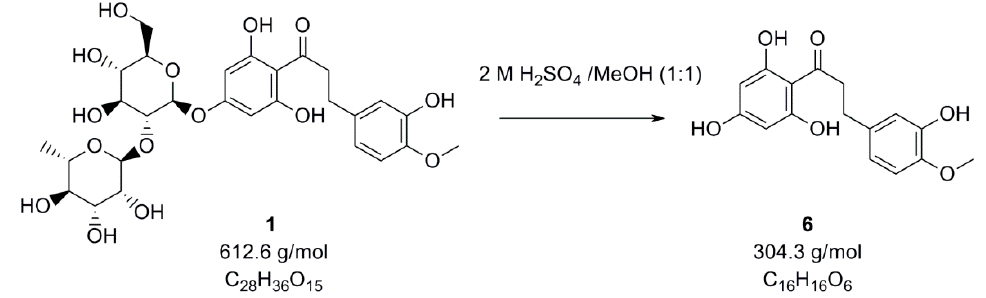
Figure A1. Preparation of compound 6 .